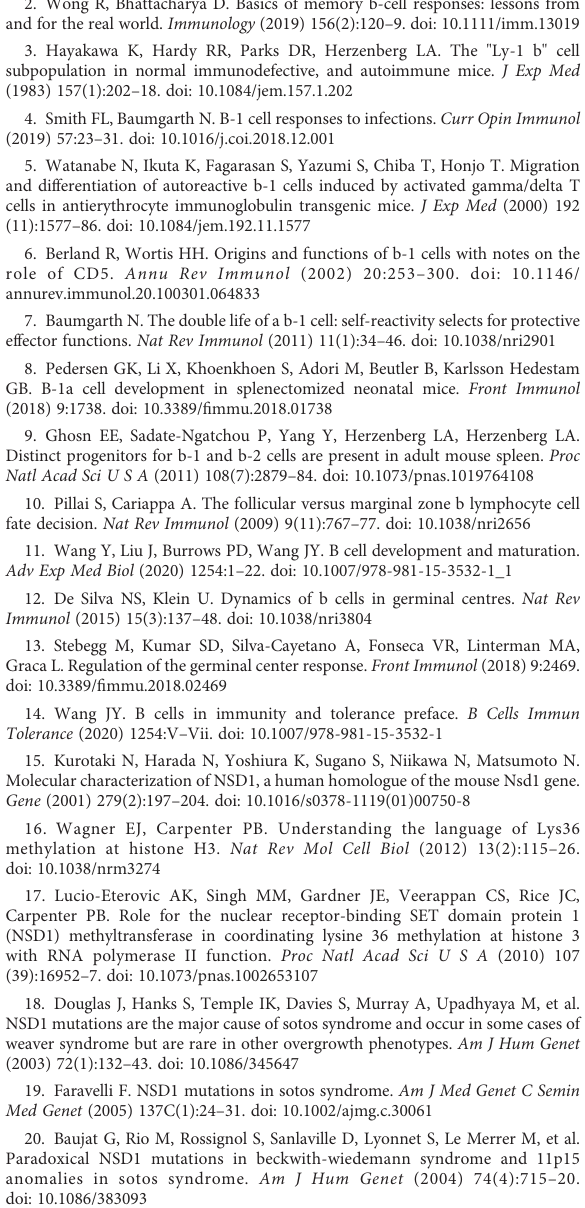
SUPPLEMENTARY FIGURE 3 Analysis of AICDA expression and SHM in NSD1 B WT and NSD1 B KO mice. (A) .Theexpressionof AICDA inthegerminalcenterBcellssortedfromthe spleen of NSD1 B WT and NSD1 B KO mice (n = 3). (B) . The frequency of JH4 and VH186.2 H chains mutations in the germinal center B cells sorted